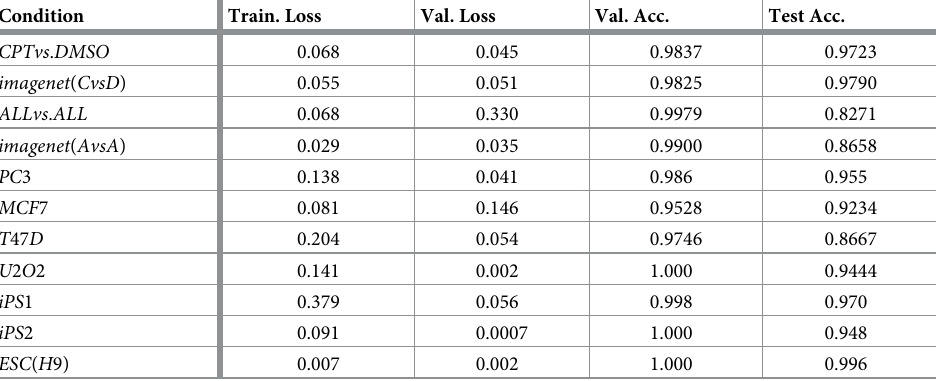
Highest value of accuracy achieved in the test set (Test Acc.) among several trainings is presented for each condition at 1h. Corresponding values of the Loss function for training (Train. Loss) and validation (Val. Loss) are shown as well as accuracy on validation set (Val. Acc.). Results of running a pretrained model on CPT vs. DMSO (imagenet CvsD) and ALL vs. ALL (imagenet AvsA) conditions were